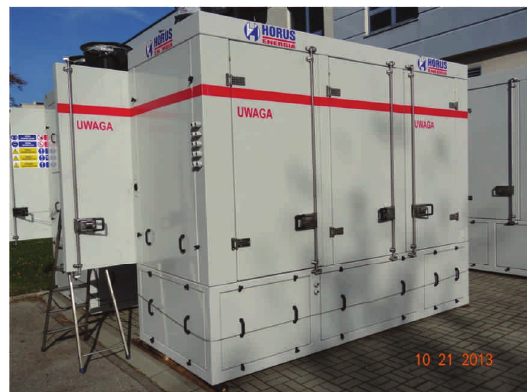
Fig. 1. View of the power-generator set while equipping with elements of the electronically controlled fuel supply system of post-processing gas, in front of the building of Engines Laboratory of Cracow University of Technology